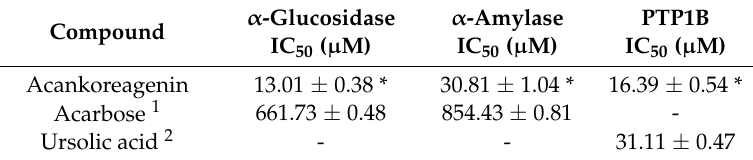
Table 1. Effects of acankoreagenin on α -glucosidase, α -amylase, and PTP1B inhibitory activities. Compound